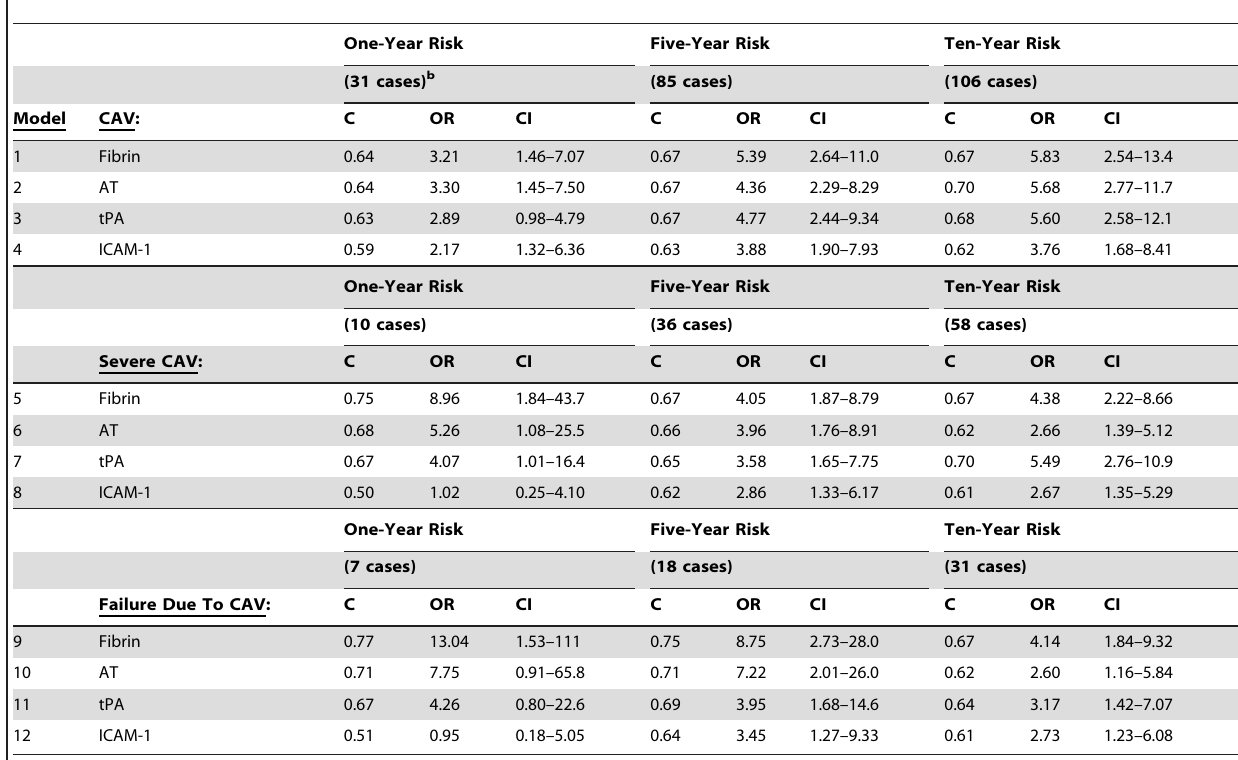
Table 2. Univariate logistic regression models using information from the first post-transplant biopsy (N=172 patients). a